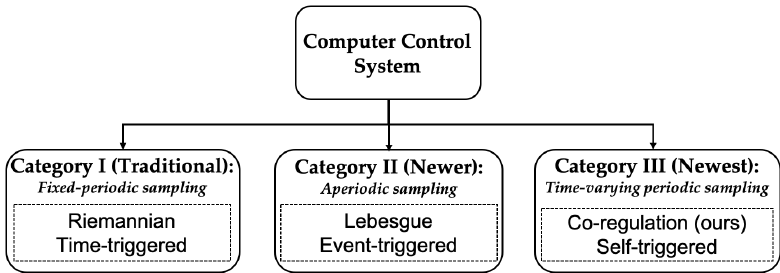
Figure 3. Three categories of control